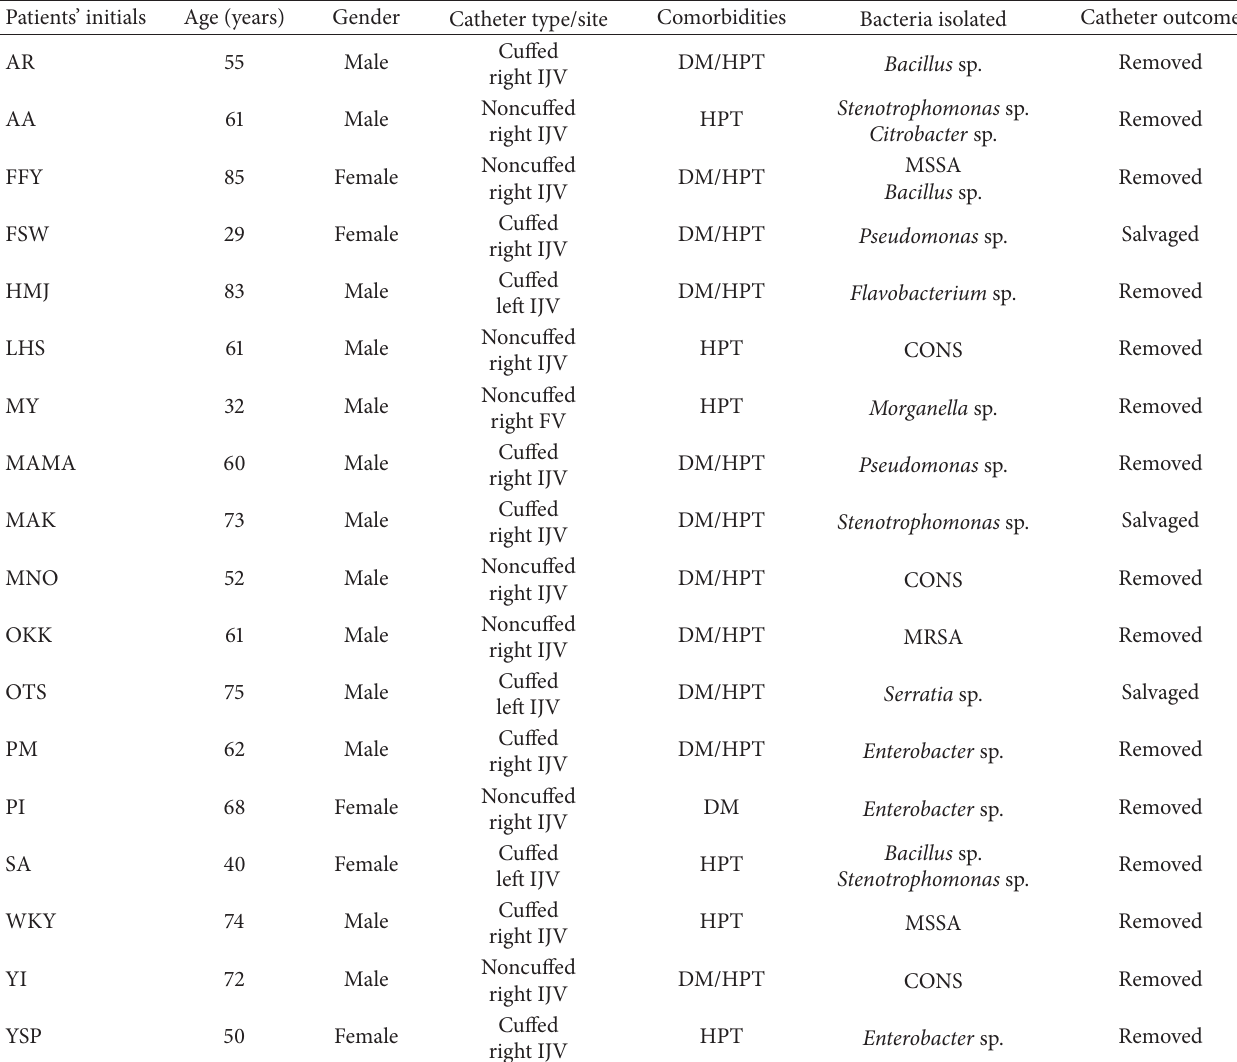
Table 1: Baseline characteristics, bacterial isolated, and catheter